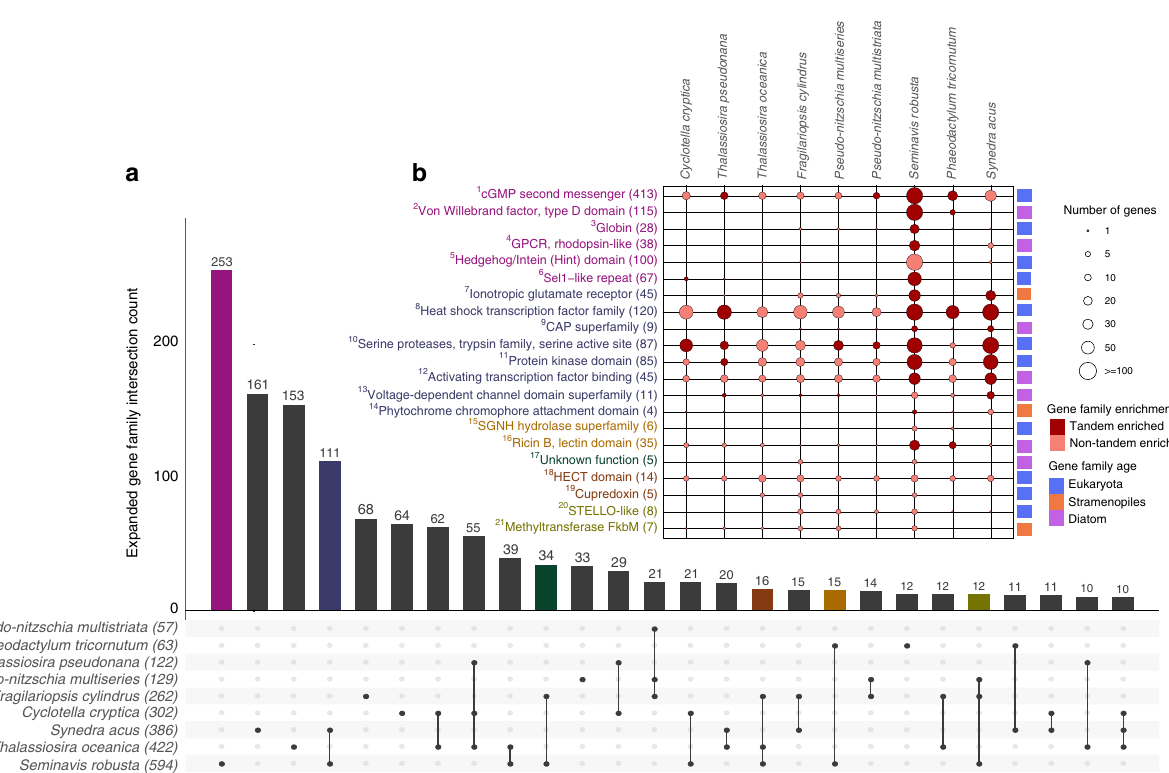
Fig. 2 Species-speci fi c and shared gene family expansions in diatoms. a Upset plot showing the intersection of gene family expansions in diatoms. Each row represents a diatom species, reporting the total number of expanded gene families within parenthesis. Black circles and vertical lines between the rows represent the intersection of expanded families between species. The barplot indicates the total gene family count in each intersection, displaying only intersections that contain at least ten gene families. Diatoms with a genome size > 90 Mb are highlighted in bold. b Examples of species-speci fi c and shared gene family expansions in S. robusta . Each column represents a diatom species, and each row a given gene family showing expansion in S. robusta , indicating the total number of genes in S. robusta in parenthesis and matching the font color with the intersection subset in panel a . The size of the circles is proportional to the number of genes falling under the given gene family per species, whereas the color of the circles indicates if the gene family is signi fi cantly tandem-enriched. Source data are provided as a Source Data fi le. Numbers in superscript refer to families annotated in this Source Data fi